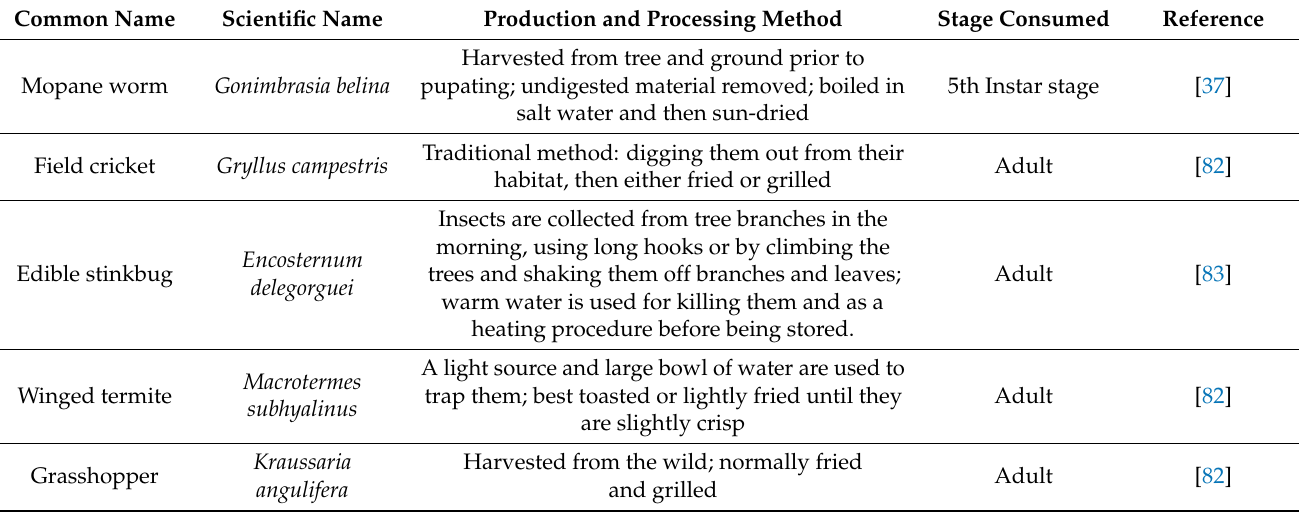
Table 1. Production and processing of common edible insects in